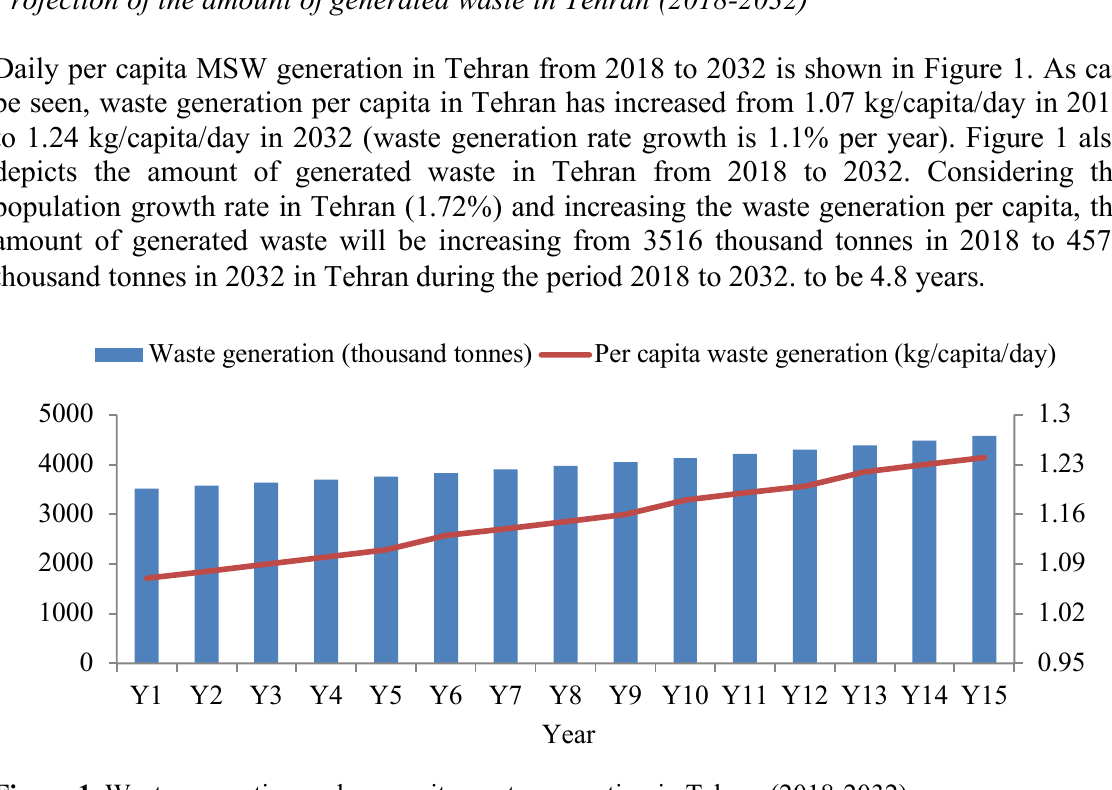
Figure 1. Waste generation and per capita waste generation in Tehran